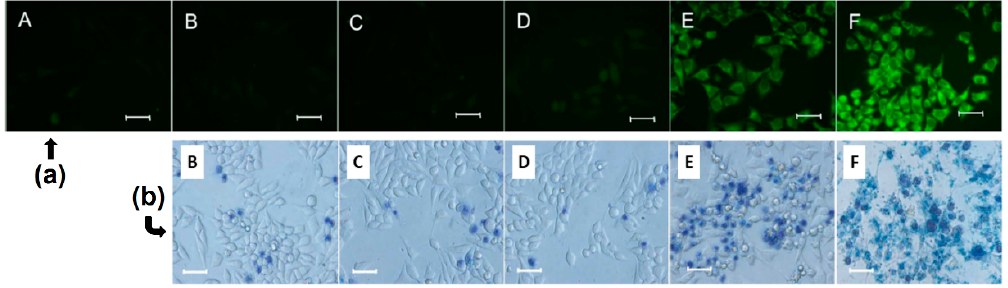
Figure 56. ( a ) Singlet oxygen sensor green (SOSG) fluorescence images of HeLa cells. ( b ) Micrographs of HeLa cells stained with trypan blue of ( A ) control cells, and when exposed to ( B ) β -CD- COOH/UCNPs, ( C ) β -CD-COOH, ( D ) Ada-ZnPc, ( E ) β -CD-COOH/UCNPs + Ada-ZnPc, and ( F ) Ada- ZnPc@ β -CD-COOH/UCNPs after 980-nm laser irradiation. Bar = 100 µm. Reproduced by permission of The Royal Society of Chemistry [192].